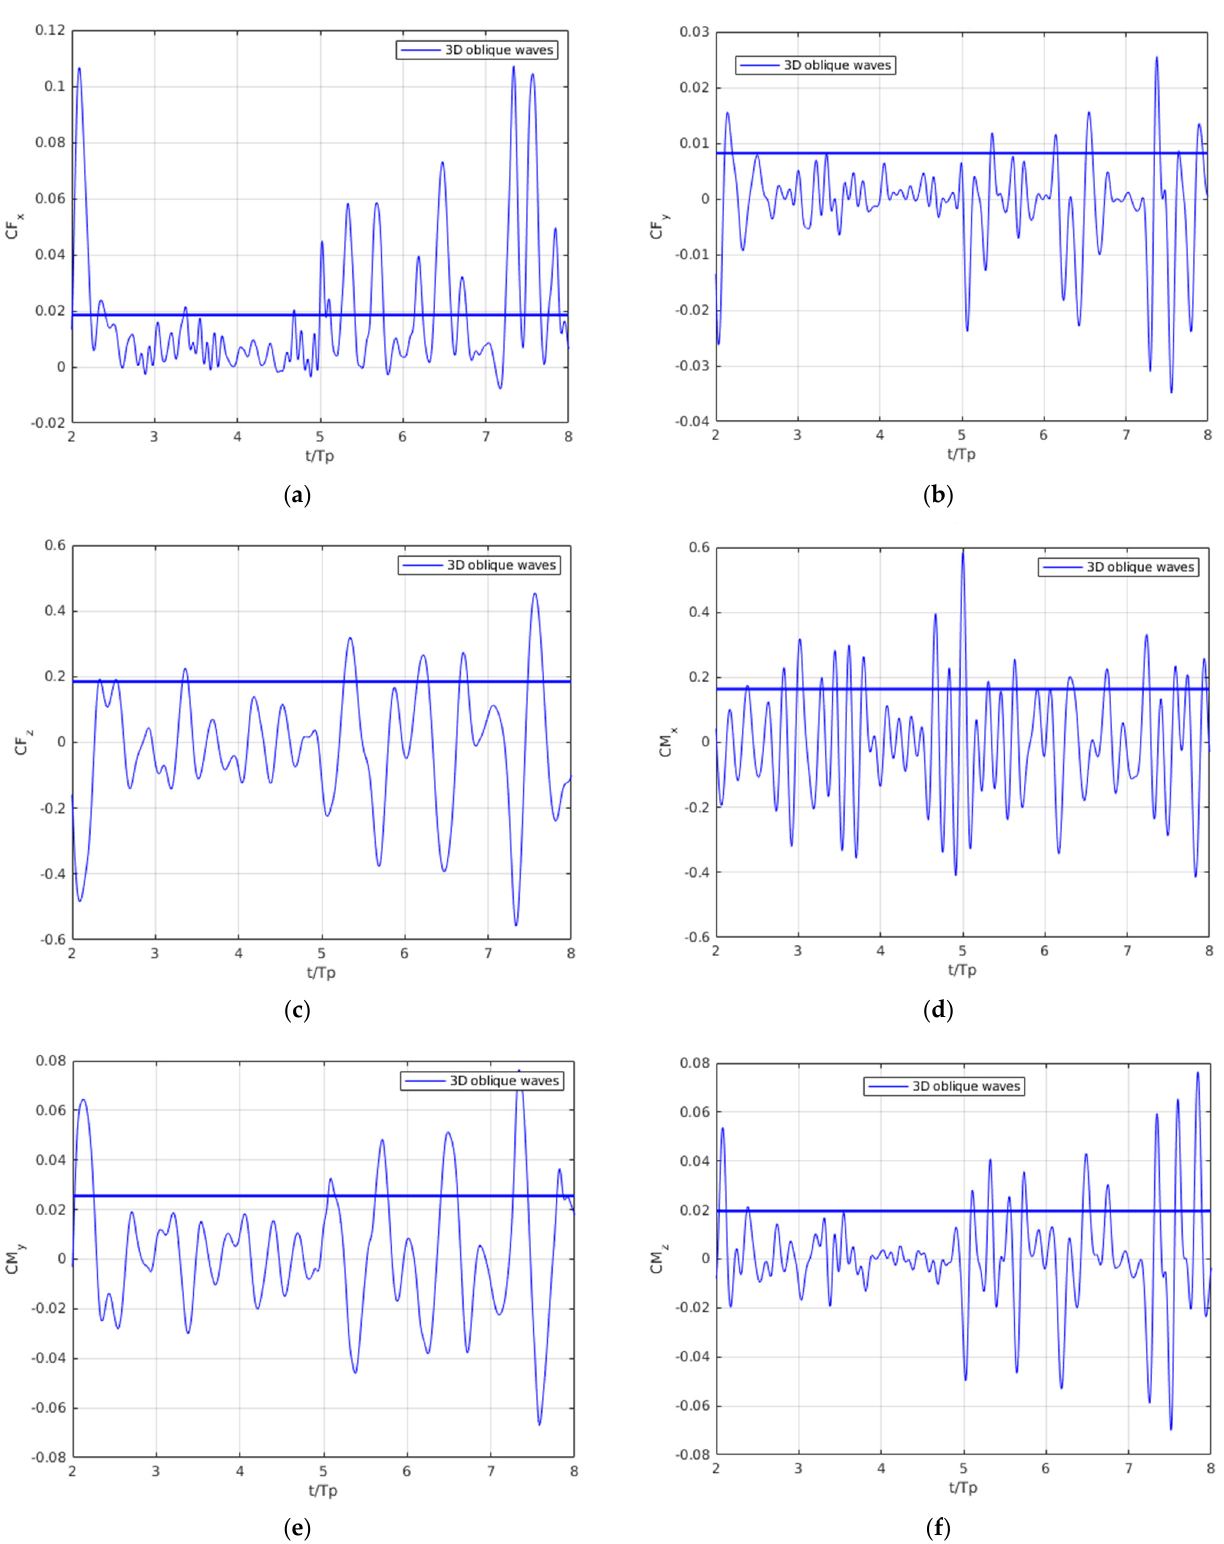
Figure 18. Time history of nondimensional forces and moments acting on the dynamic wing operating in quartering seas ( β = 150 ◦ ) for the case of Figure 17: ( a ) thrust C Fx = F x /0.5 ρ U 2 cs ; ( b ) force in spanwise direction C Fy = F y /0.5 ρ U 2 cs ; ( c ) vertical force C Fz = F z /0.5 ρ U 2 cs ; ( d ) twisting moment C Mx = M x /0.5 ρ U 2 c 2 s ; ( e ) pitching moment C My = M y /0.5 ρ U 2 c 2 s ; ( f ) wing yawing moment C Mz = M z /0.5 ρ U 2 c 2 s